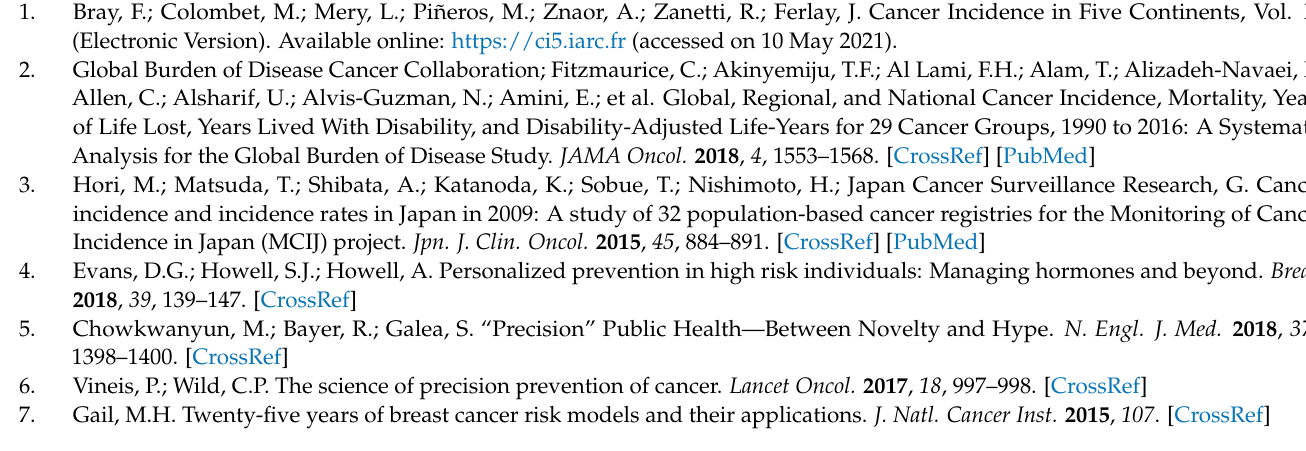
Table S2: ORs of genetic risk groups stratified by menopausal status, Figure S1: Calibration plot of the inclusive model in the total population, Table S3: C-statistics of genetic, environmental and inclusive risk models stratified by menopausal status, Table S4: C-statistics of genetic risk score models including 14, 22 and 42 SNPs, Table S5: C-statistics of three levels of genetic risk score model, risk score model and allelic risk